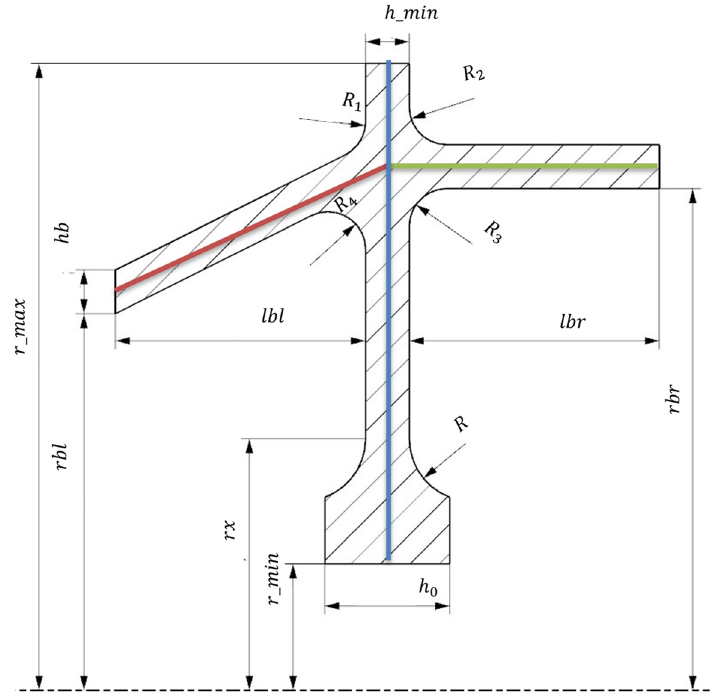
Figure 2. Parametric model of the disc with indication of the main dimensions. Colours indicate the paths along which the stresses for optimisation were determined.